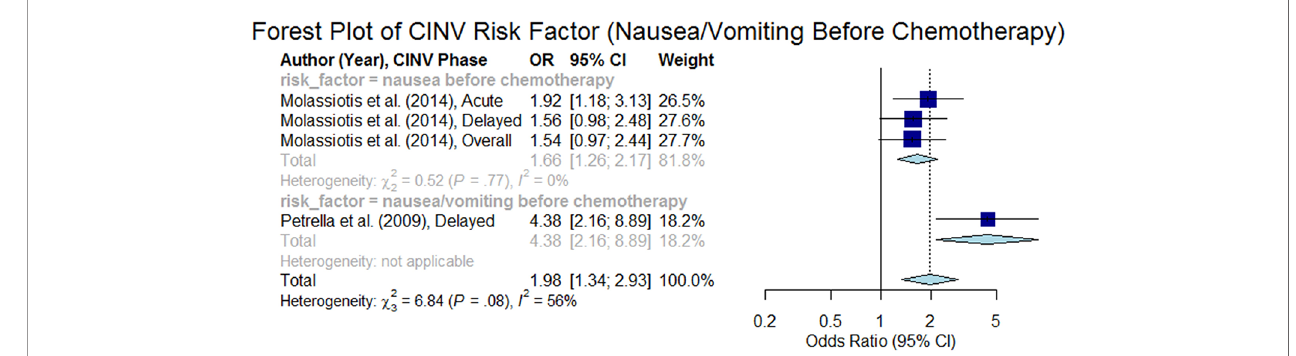
FIGURE 12 | Forest plot of Chemotherapy-Induced Nausea and Vomiting (CINV) risk factor (nausea/vomiting